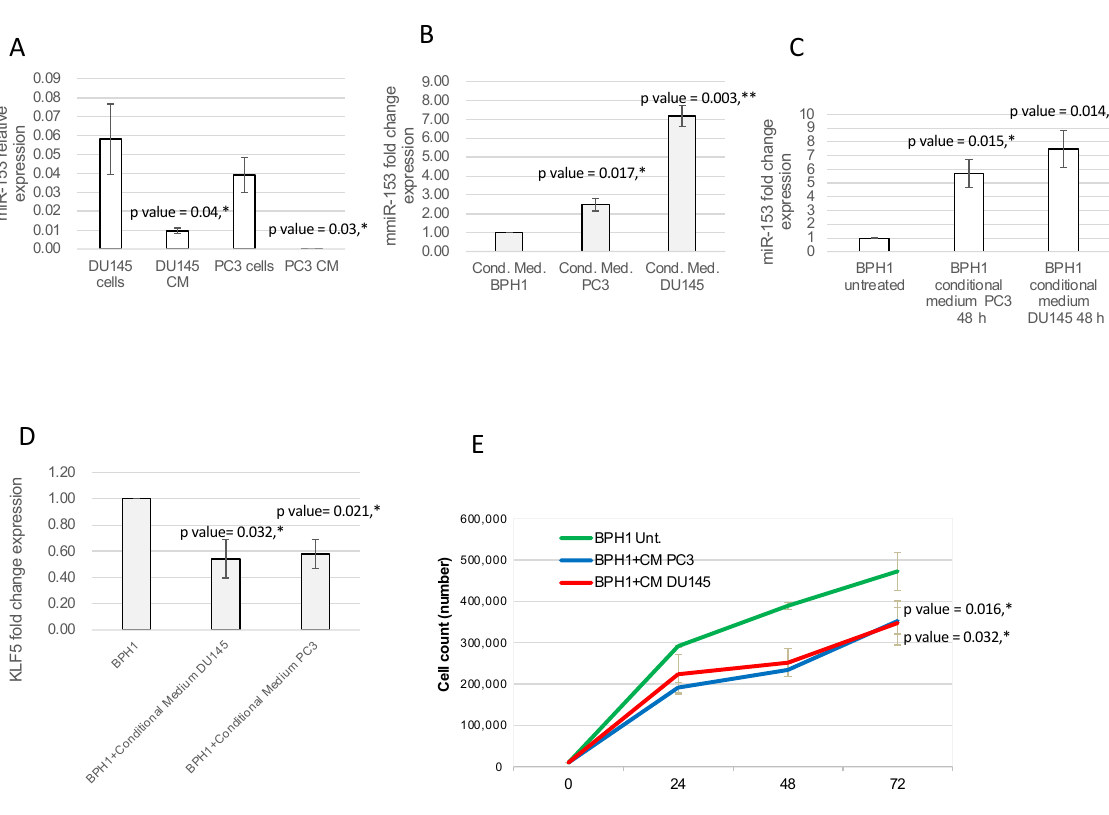
Figure 8. Secreted miR-153 can enter in the surrounding cells. ( A ) DU145 and PC3 can secrete miR-153 in the conditional medium. RT-qPCR analysis (relative expression, 2 − ∆∆ CT ± sd) of miR-153 and internal control was performed on conditional medium collected from DU145 and PC3 cell lines ( t test, p value ≤ 0.05, *). ( B ) miR-153 is highly expressed in conditional medium from PC3 and DU153 cells compared to BPH1 (miR-153 fold change expression, as 2 − ∆∆ CT ± sd values, is shown; t test, p value ≤ 0.05, *; 0.01, **). ( C ) DU143 and PC3 conditional medium is able to enter into BPH1 cells, significantly increasing its inner level of expression (miR-153 fold change expression, as 2 − ∆∆ CT ± sd values, is shown; t test, p value ≤ 0.05, *). ( D ) KLF5 fold change expression (2 − ∆∆ CT ± sd values) is significantly affected by internalized miR-153. t test p values compared to untreated BPH1 cells are indicated ( n = 2 experiments performed in triplicate; t test, p value ≤ 0.05, *). ( E ) Count of BPH1 cells in standard medium or in conditional medium (CM) from DU145 or PC3. t test p values compared to untreated BPH1 cells are indicated ( n = 2 experiments performed in triplicate; t test, p value ≤ 0.05,